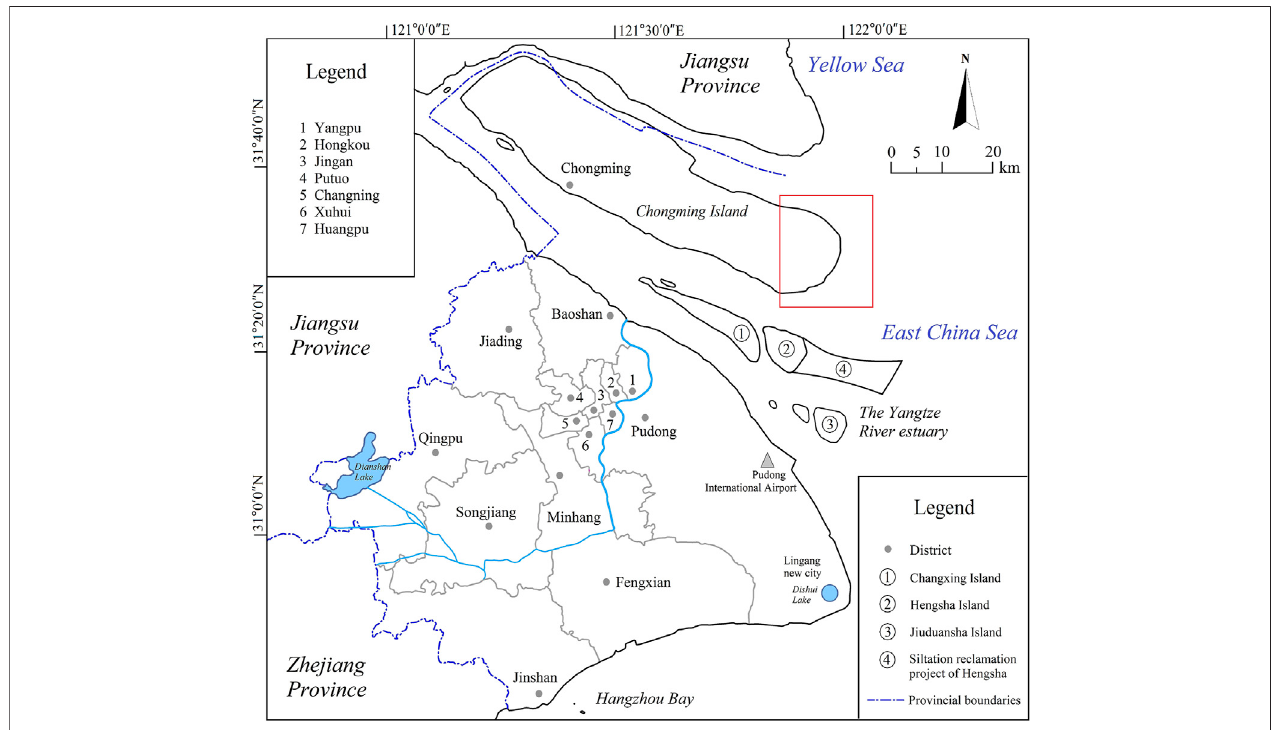
FIGURE 1 | The geographical location of eastern Chongming Island, Shanghai City.